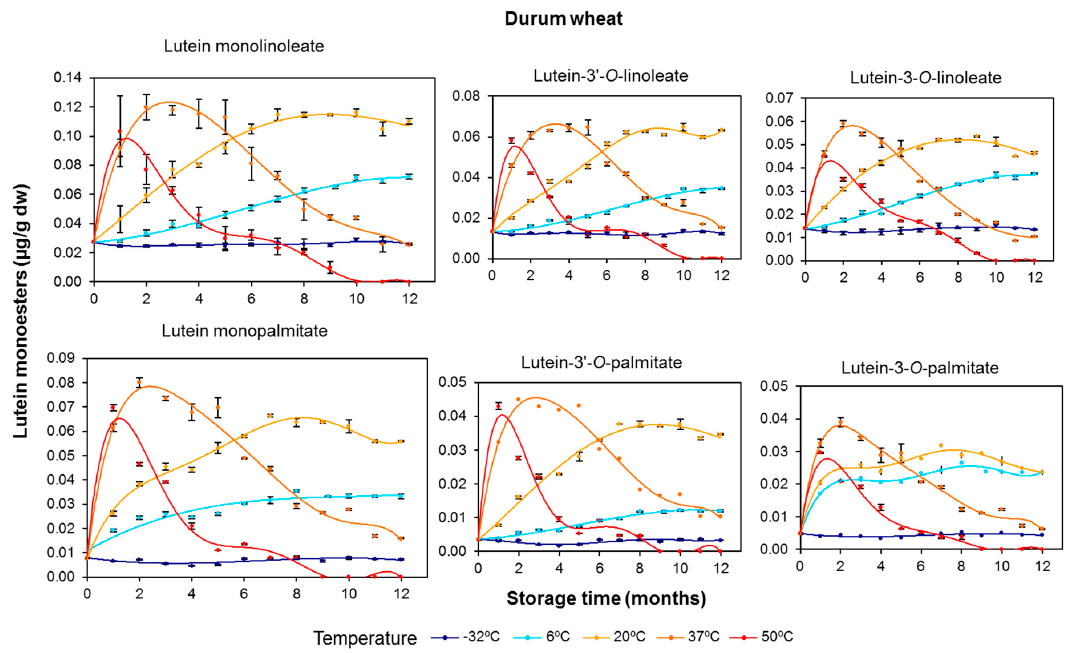
Figure 4 Figure 4. Quantitative changes in the xanthophyll ester fractions ( µ g/g dry weight) in durum wheat (Don Pedro variety) whole-grain flours during long-term storage under temperature controlled conditions ( − 32, 6, 20, 37 and 50 ◦ C). The values shown are the mean and standard error ( n = 5 for the starting sample, n = 3 for the rest of the